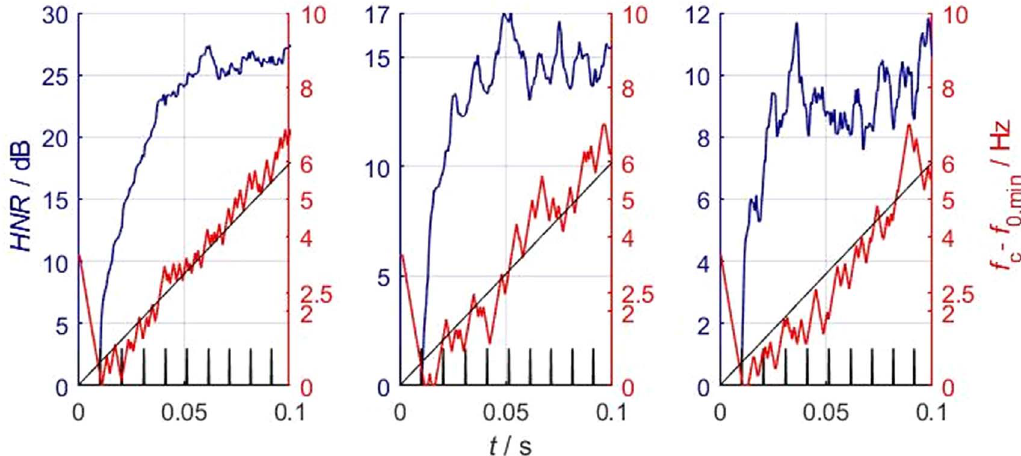
Figure 5. Complex tone with a linear sweep of the fundamental frequency from 96 Hz to 103 Hz (simulation IV). SNR decreases from left to right panel, data presentation is as in Figure 3. Data clearly show quick convergence and an ongoing locking with a delay that is shorter than one period, even at the lowest SNR of 1.4 dB (right panel). Note that the total duration of the signal is only 100 ms.